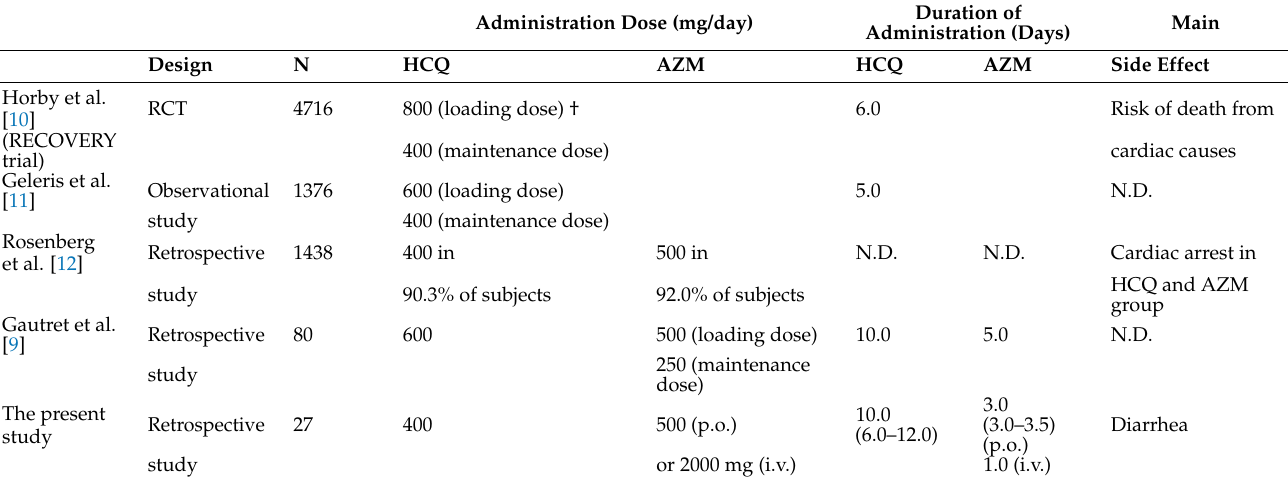
Table 2. Present and previous reports of HCQ